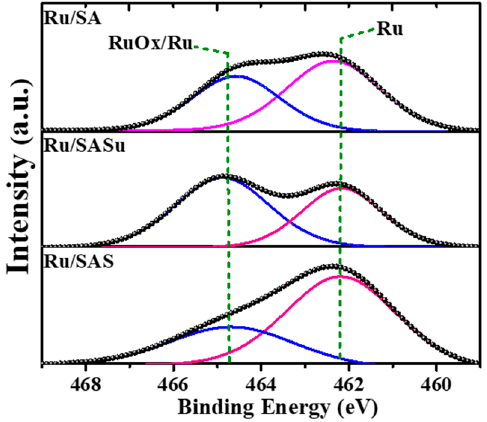
Figure 3. Ru 3p XPS spectra of the three studied catalysts. TheRu3pfittedspectraofthethreeRucatalystsrevealthepresenceofmetallicRu(B.E = 462.3 eV)